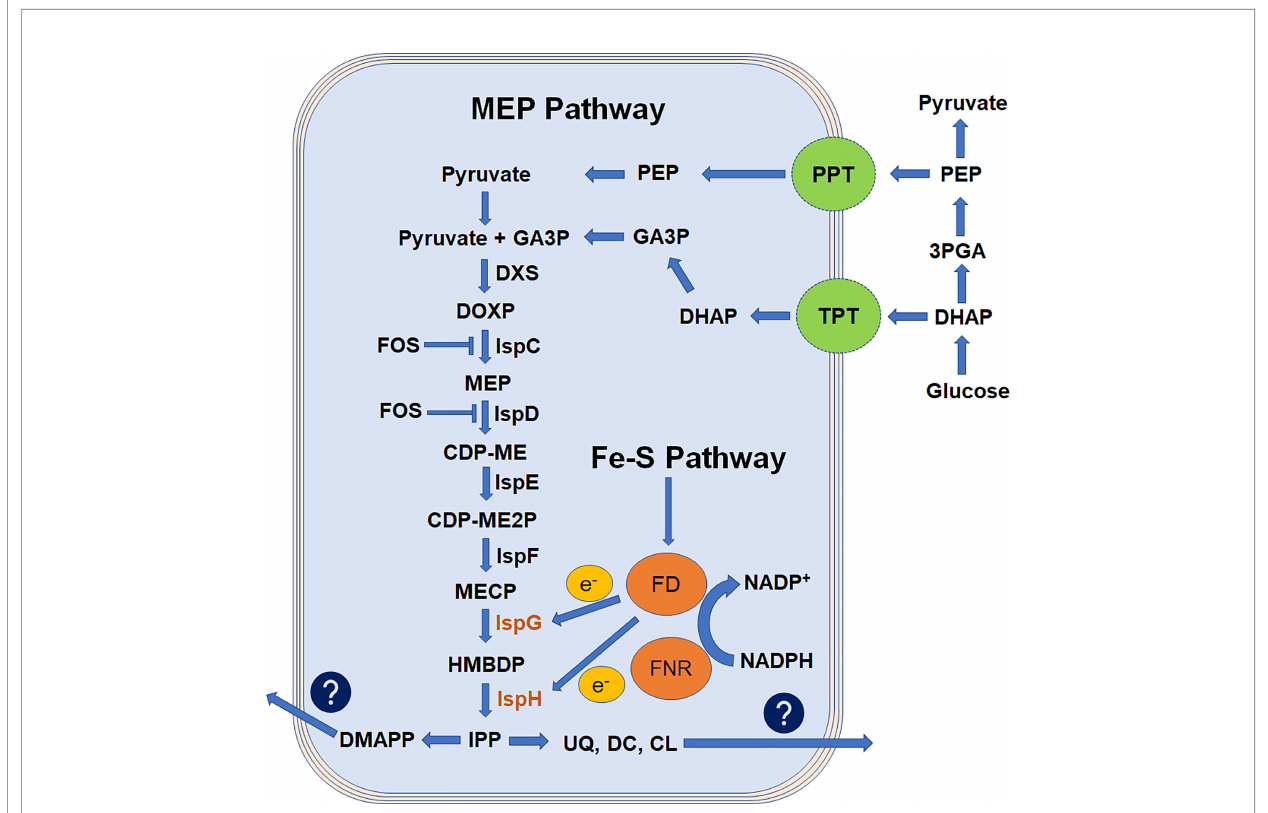
FIGURE 1 | Flowchart representation of apicoplast MEP pathway adapted from Saggu, 2016. Isoprenoids are derived from the basic 5-carbon isoprenoid building blocks of IPP and its isomer, DMAPP. In the MEP pathway, IPP and DMAPP are generated from pyruvate and GA3P and thought to be transported by putative transporter TPT and PPT. Enzymes of this pathway are encoded by parasite nuclear genome and targeted to apicoplast by NEAT sequence. Pathway products are exported out of the apicoplast to parasite cytosol with an unknown mechanism. FOS inhibits the rate-limiting steps of this pathway and blocks the biosynthesis of isoprenoids. Ferredoxin is reduced by the NADPH-dependent enzyme ferredoxin-NADP + reductase and is believed to provide electrons to IspG and IspH enzymes. The MEP pathway is a cascade of enzymatic reactions where inhibition of any step could impede the parasite growth. However, the reduced condition made IspG and IspH enzymes more critical. 3PGA, 3-phospho-glyceraldehyde; CDP-ME, 4-diphosphocytidyl-2C-methyl- D -erythritol; CDP-ME2P, 4- diphosphocytidyl-2C-methyl- D -erythritol-2-phosphate; CL, cholesterol; DC, dolichols; DHAP, dihydroxyacetone phosphate; DMAPP, dimethylallyl pyrophosphate; DXS, 1-deoxy- D -xylose-5-phosphate synthase; DOXP, 1-deoxy- D -xylose-5-phosphate; DXS, 1-deoxy- D -xylulose 5-phosphate synthase; FOS, fosmidomycin; GA3P, glyceraldehyde-3-phosphate; HMBDP, 4-hydroxy-3-methyl-2-(E)-butenyl-4-diphosphate; IPP, isopentenyl-5-pyrophosphate; IspC, 2C-methyl- D -erythritol 4-phosphate synthase; IspD, 4-diphosphocytidyl-2C-methyl- D -erythritol synthase; IspE, 4-diphosphocytidyl-2C-methyl- D -erythritol kinase; IspF, 2C-methyl- D - erythritol 2,4-cyclodiphosphate synthase; IspG, 2C-methyl- D -erythritol 2,4-cyclodiphosphate reductase; IspH, 1-hydroxy-2-methyl-2-(E)-butenyl-4-diphosphate reductase; MECP, 2C-metyl- D -erythritol 2,4-cyclodiphosphate; MEP, 2C-methyl- D -erythritol 4-phosphate; PEP, phosphoenolpyruvate; PPT, phosphoenolpyruvate transporter; TPT, triose-phosphate transporter; UQ,